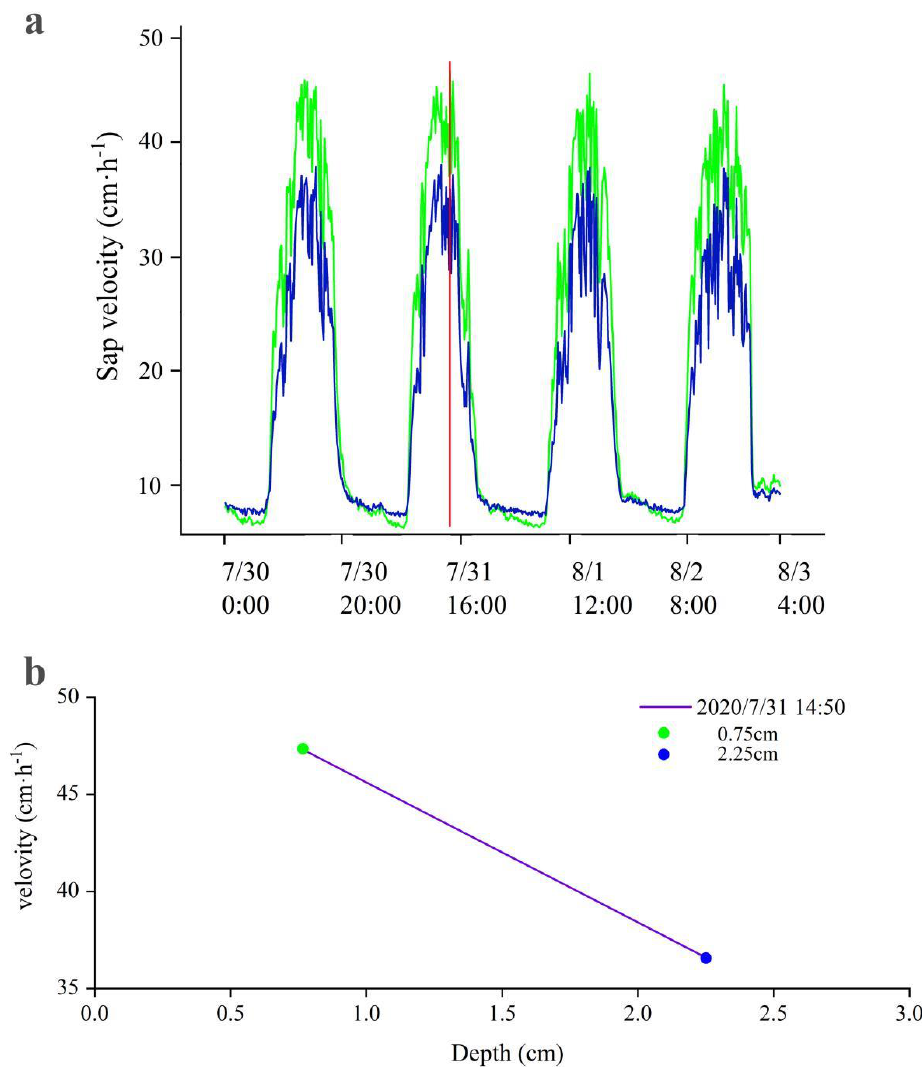
Figure 4. Changes in the sap flow of the Golden Pear from 30 July to 2 August 2020. ( a ) Flow rate variation. ( b ) Changes in the radial distribution of flow velocity at 14:50 on 31 July. The green line shows the sap flow rate at 0.75 cm from the tree, and the blue line shows the sap flow rate at 2.25 cm. The red line in ( a ) refers to the flow rate at 14:50 on 31 July, and the radial change is more clearly shown in ( b ). Graphics are drawn by origin